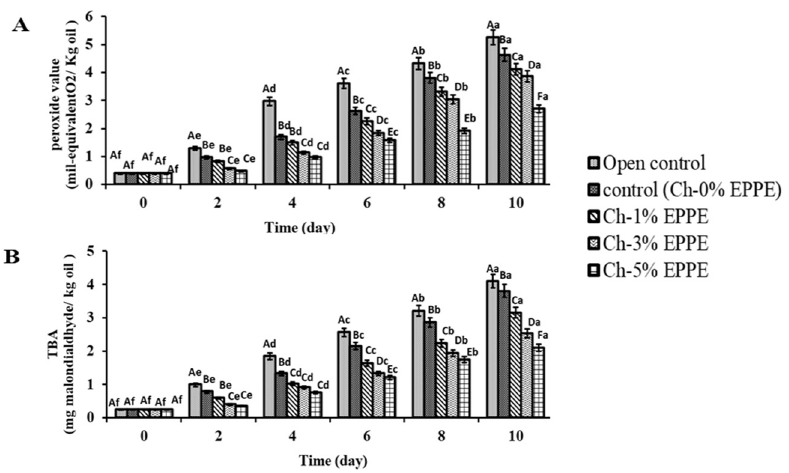
Figure 3. Changes in the PV ( A ) and TBARS ( B ) levels in corn oil stored in Ch-EPPE films at 50 °C for 10 days. Data are presented as means ± SD of triplicates. Different lowercase letters indicate the statistically significant difference ( p < 0.05) within the same treatment group at different storage times. Different uppercase letters indicate the statistically significant difference ( p < 0.05) among different treatment groups at the same storage time.